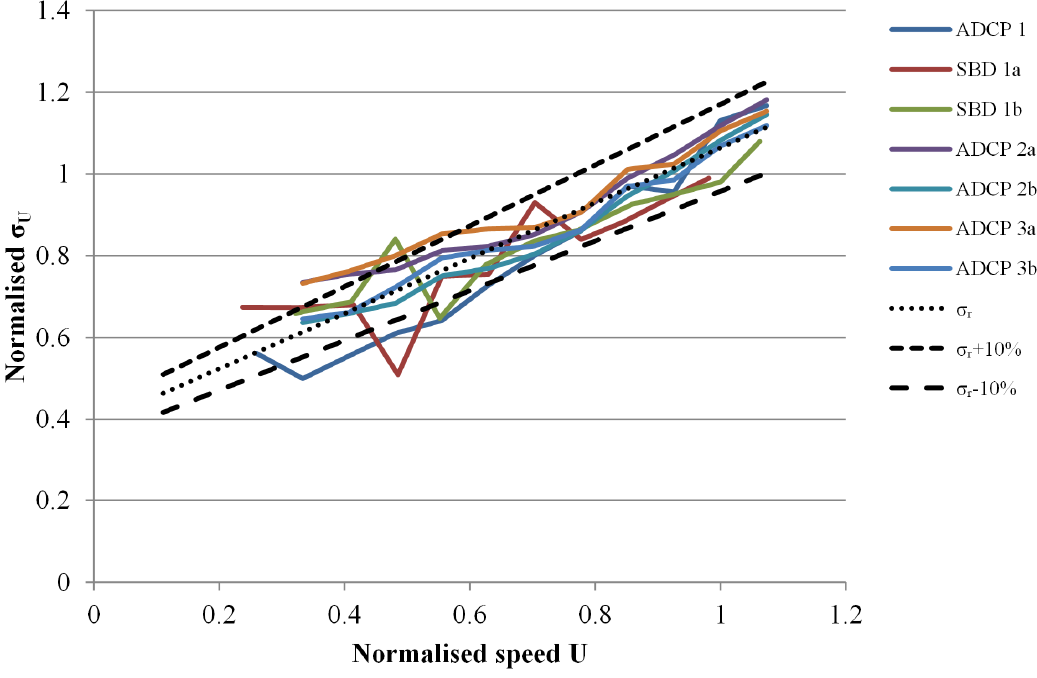
Figure 1. Flood direction σ U measurements.